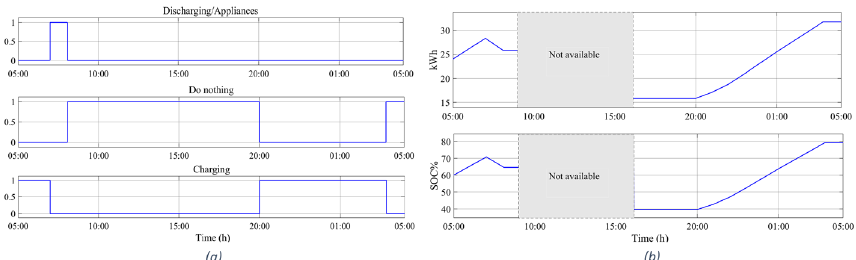
Fig. 14 a PEV management fuzzy controller output, b PEV power and